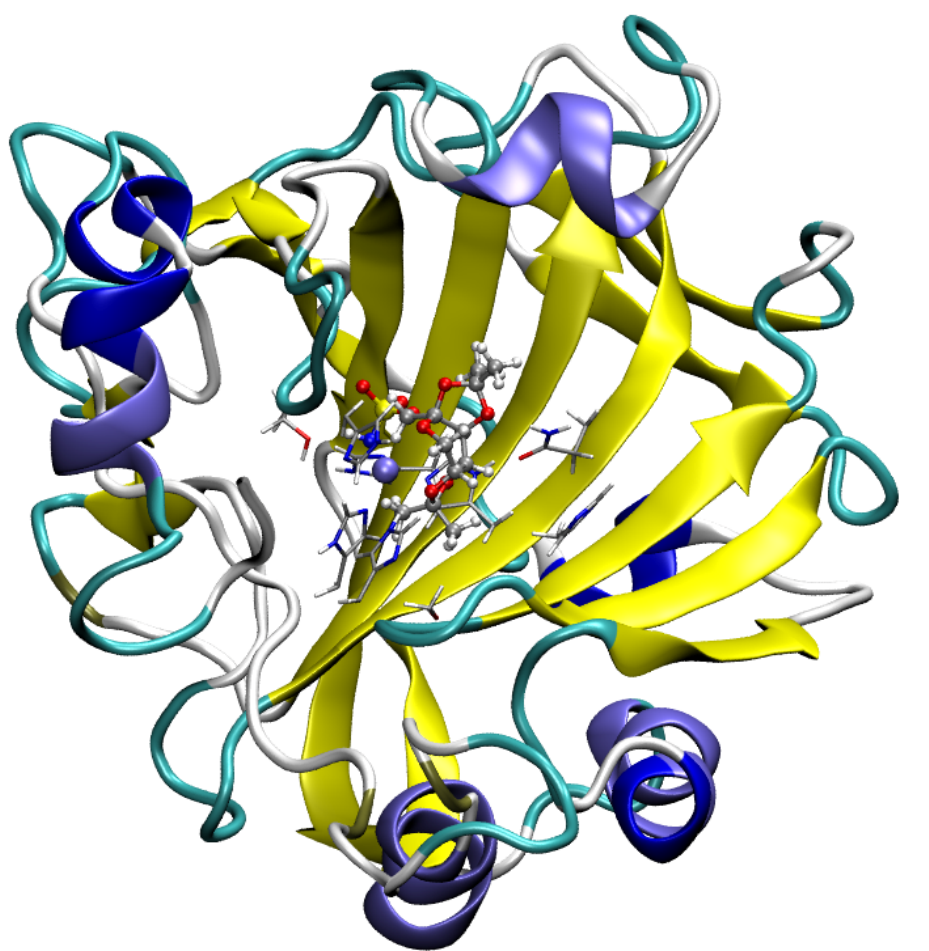
Figure 1. Graphical representation of the model used in the QM/MM molecular dynamics simulations (MM and QM water molecules have been omitted for clarity). The binding site and Topiramate are represented using the CPK model (this part was treated at the QM level), while the rest of the protein (treated at the MM level) was visualized with the cartoon representation. Color coding: white—hydrogen, cyan—carbon, red—oxygen, blue—nitrogen, yellow—sulfur, and